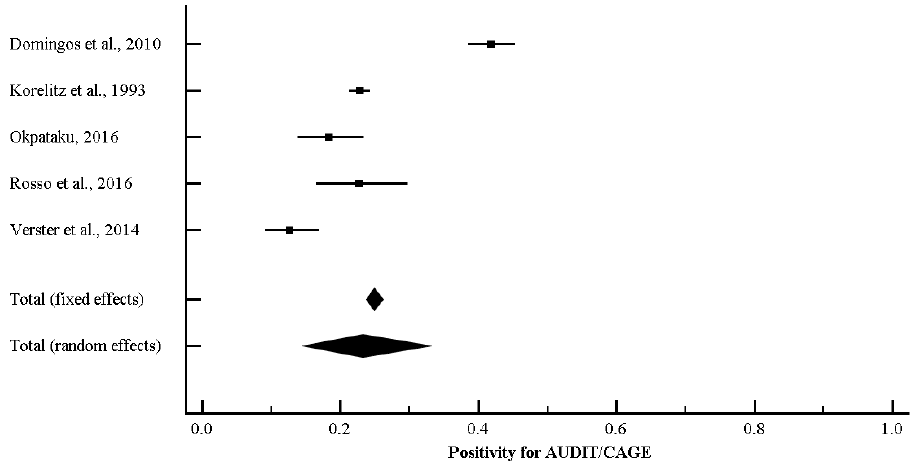
Figure 8. Forest plot for positivity to AUDIT-CAGE instruments rate among truck-drivers.